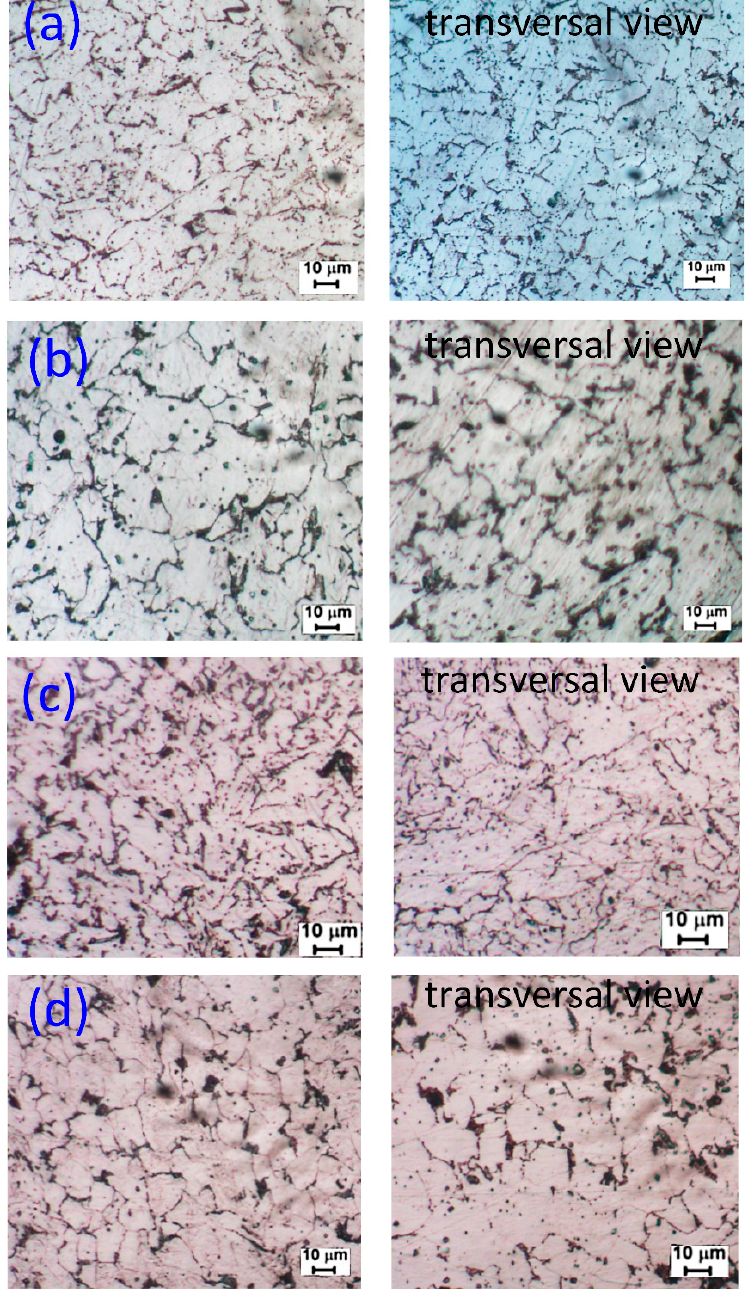
Figure 2. Microstructure of samples at di ff erent WAAM strategies: ( a ) strategy 1, ( b ) strategy 2, ( c ) strategy 3, and ( d ) strategy 4.